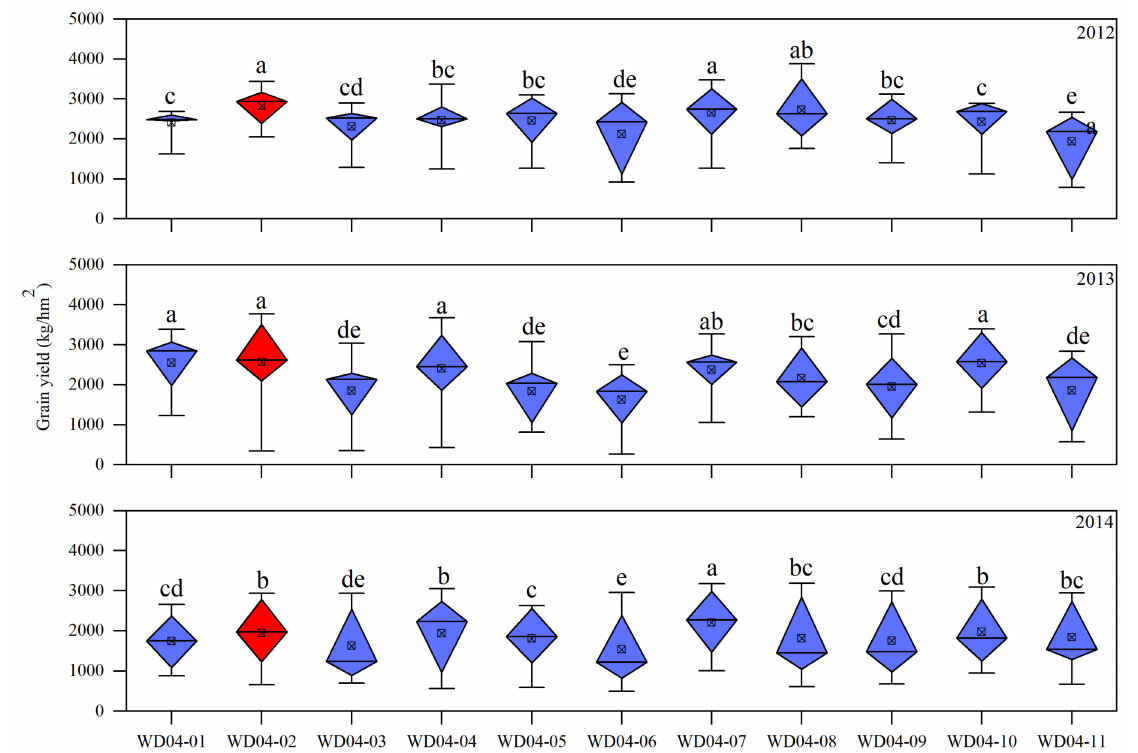
Figure 6. Grain yields of the fourth round of regional trials of China pea cultivars in the winter sowing group. The different lowercase figures above indicate significant differences between treatments ( p =